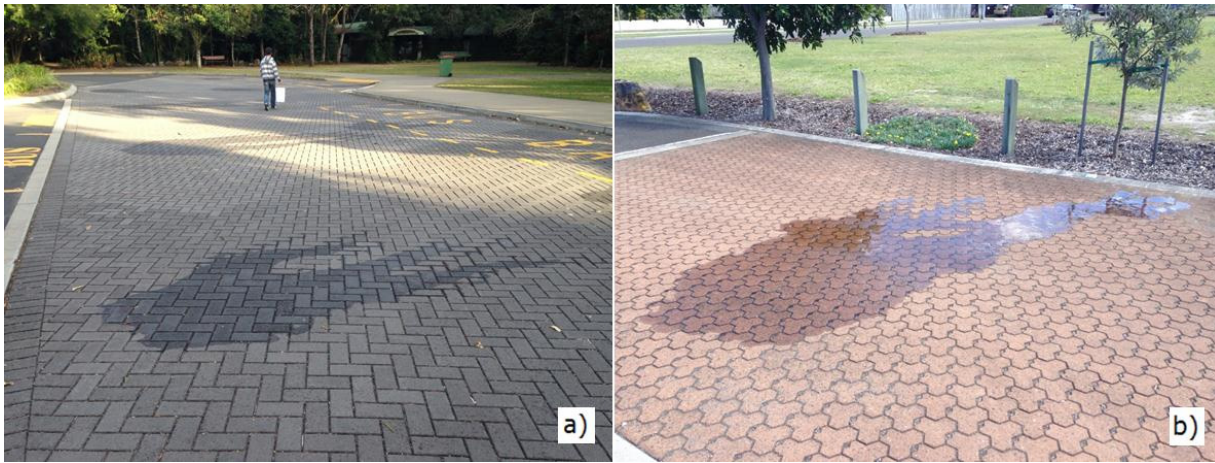
Figure 4. Six sub-site test locations at Site 1.